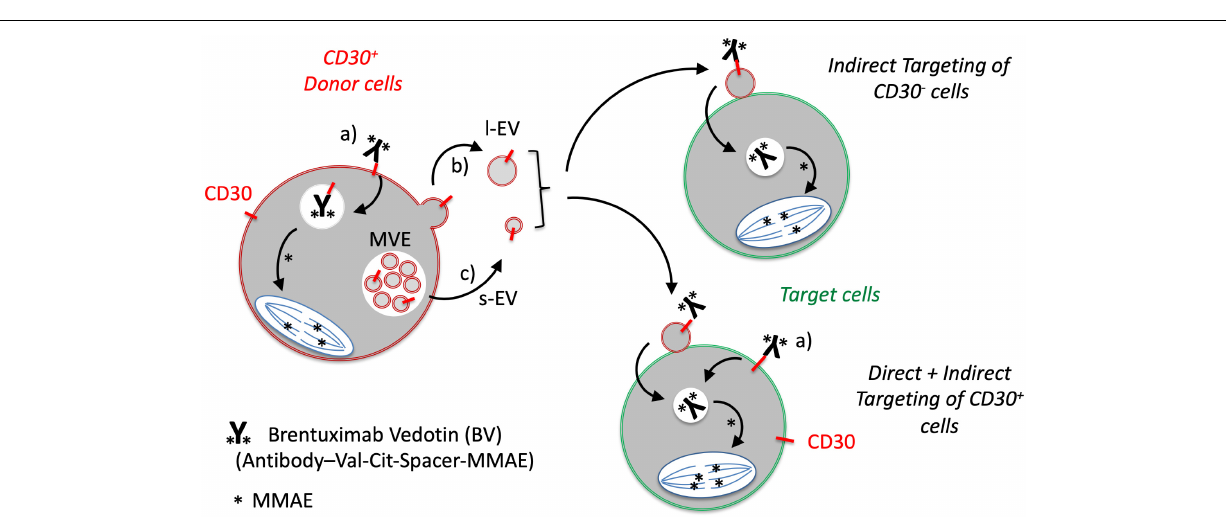
FIGURE 4 | Proposed model for the role of EVs in the targeting of CD30-negative tumor cells with the CD30 antibody drug conjugate BV. CD30 is expressed by a number of malignant DLBCL cells and activated immunoblasts. a) The CD30 ADC BV binds to CD30 + tumor cells, is internalized and the cytotoxic compound monomethylauristatin E (MMAE; ∗ ) is selectively cleaved and activated at the dipeptide valine (Val)-citrulline (Cit) by the lysosomal peptidase cathepsin B. CD30 is also released in b) large EVs (l-EVs) by budding from the surface and c) in small EVs (s-EVs) by plasma membrane fusion of multivesicular endosomes. d) CD30